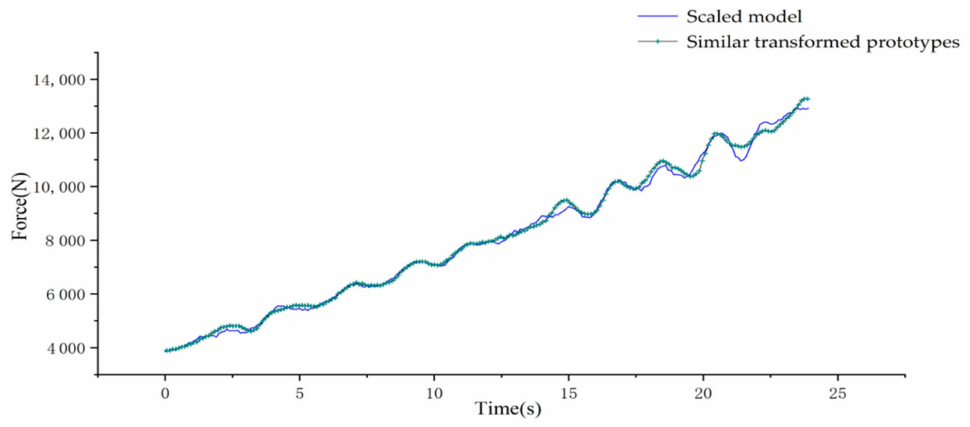
Figure 12. Stress at the hinge of the tower and lower support part of tensioner